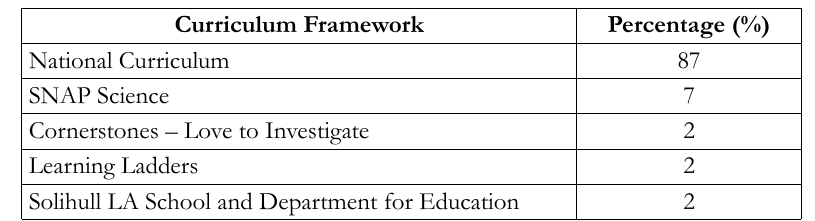
Table 2. Percentage of responses from teachers using a curriculum framework (Questionnaire)